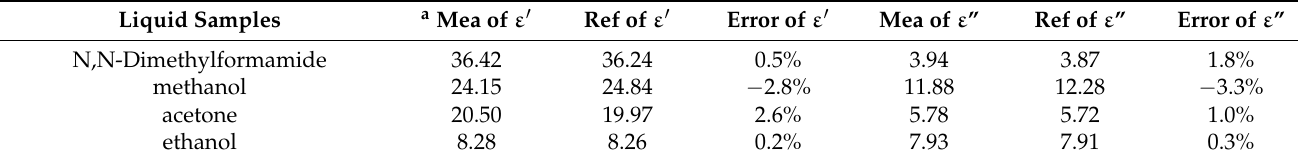
Table 3. Complex permittivity obtained by measurement.